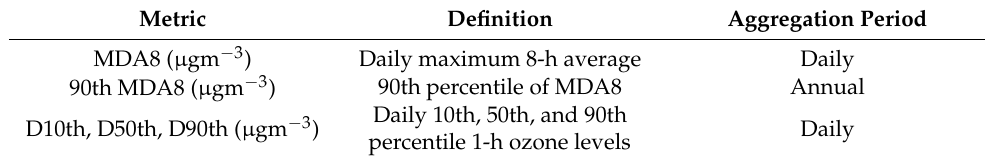
Table 1. Description of the ozone metrics used in this study.